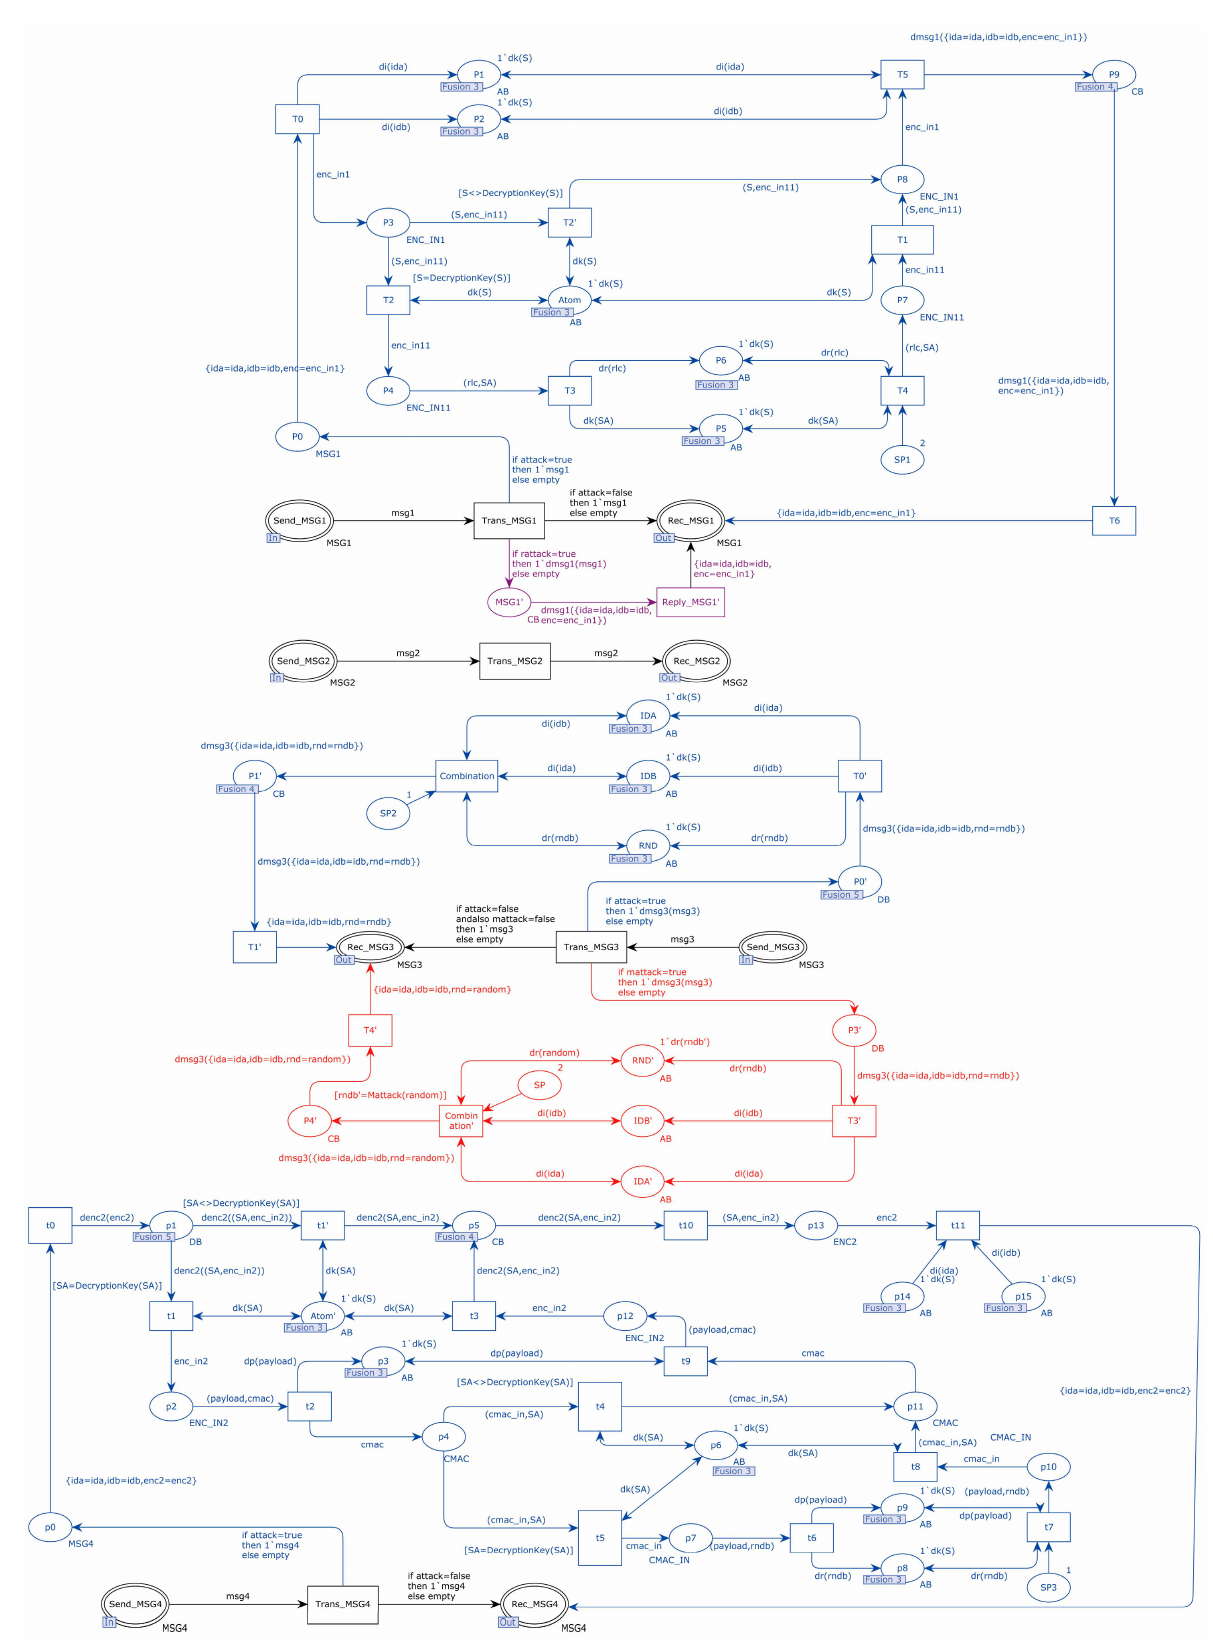
Figure 7. EnOcean protocol attacker